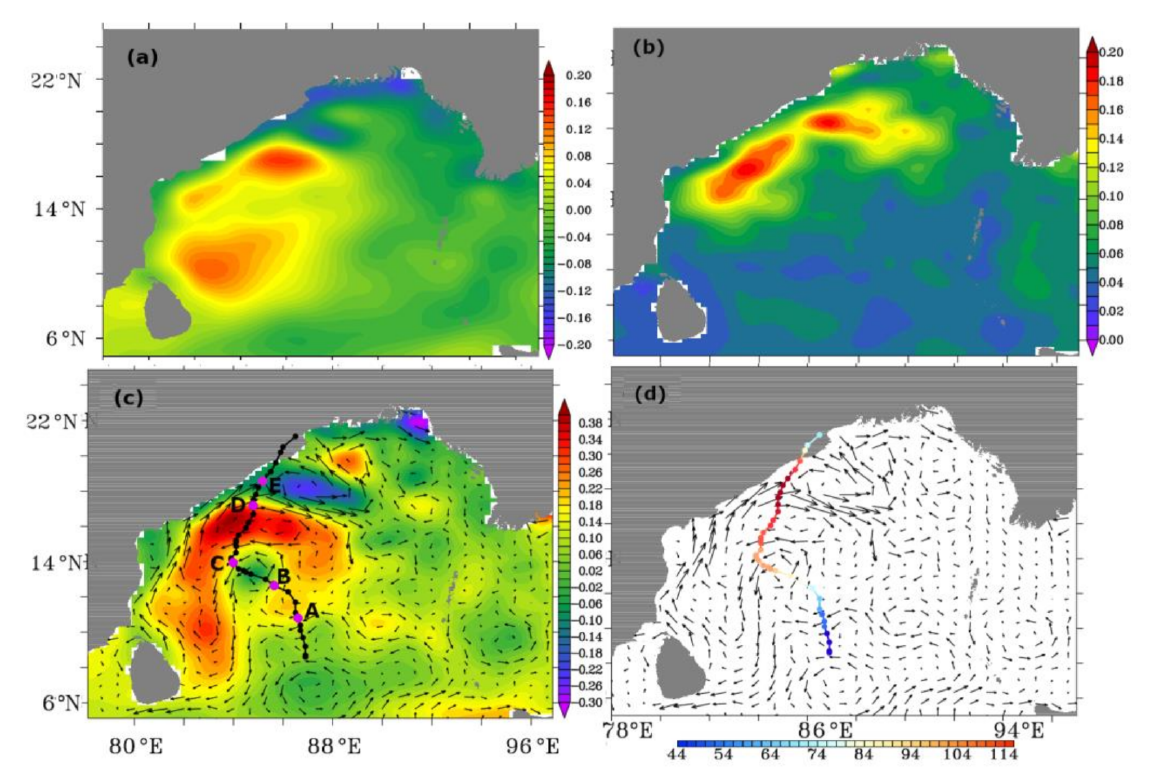
Figure 7. ( a ) Sea level anomaly (m) from AVISO climatology, ( b ) standard deviation of sea level anomaly (m) for April calculated from AVISO data, ( c ) sea level anomaly on 29 April 2019 overlay with OSCAR current vectors and IMD best-track of TC Fani, ( d ) OSCAR current vectors and IMD best-track with intensity (m/s) shown in colour shades. The black dots marked with A, B, C, D, E in panel ( c ) highlight the locations where the TC enters into or exits from a cyclonic or anticyclonic